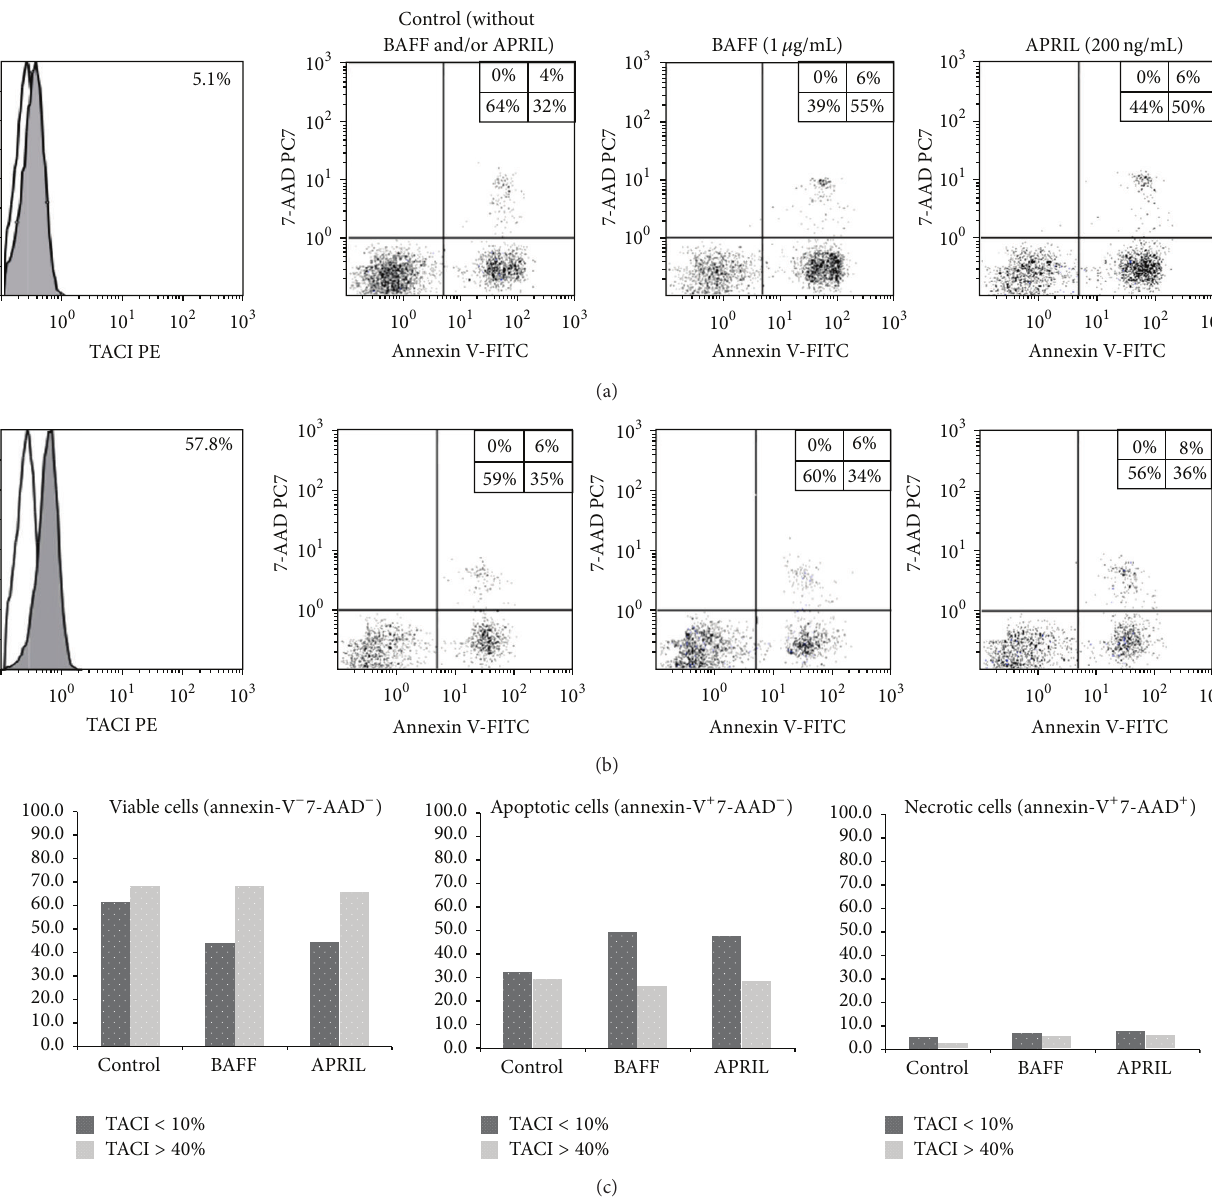
Figure 2: TACI expression protects CLL cells from apoptosis in vitro. CLL cells with very low (a), or high (b) TACI expression were cultured with IMDMmedium withoutany stimulus(internalcontrol)orstimulatedby either BAFForAPRILfor24 h.Cellswereharvested and stained with Annexin V ( 𝑥 -axis) and 7-AAD ( 𝑦 -axis) to discriminate between viable (double negative), apoptotic (Annexin V-FITC positive, 7-AAD negative), and necrotic (double positive) cells. Results are summarized in the bar graphs in the lower panel of the figure (c) and are obtained from three independent experiments in 6 CLL patients with low (3 patients; mean: 3.2%, range: 1.7%–5.1%) and high TACI expression (3 patients; mean: 49.7%, range: